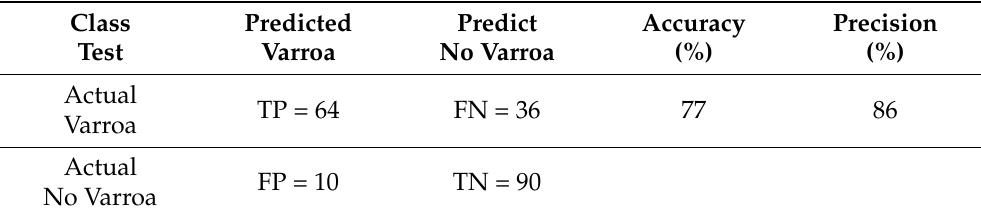
Table 6. Accuracy and Precision of image processing step on CNN bee-detected contours using HSV color masking and Hough